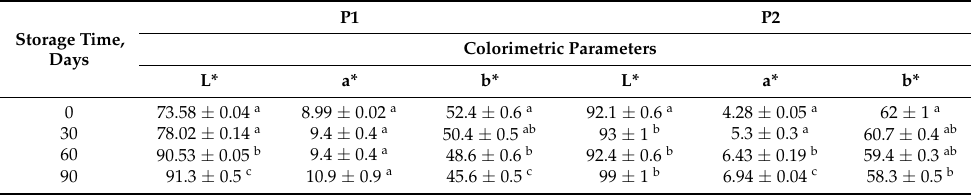
Table 4. Storage stability of color from